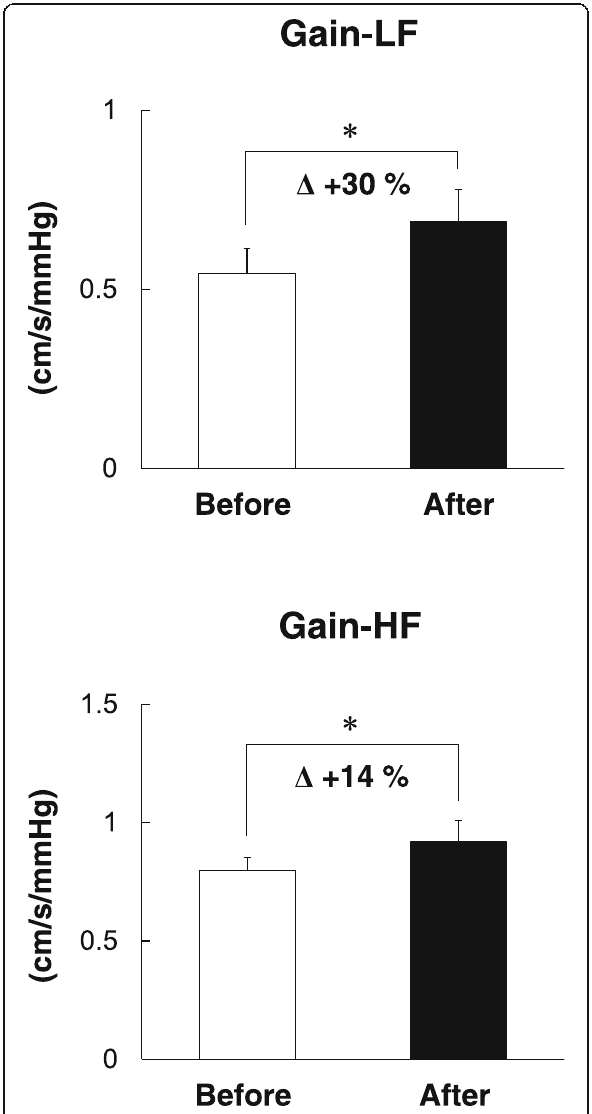
Fig. 2 Group-averaged transfer function gain before and after the 14-day confinement period in an isolated environment. * P < 0.05 comparison between before and after the 14-day confinement period in an isolated environment. Δ , percentage change between before and after the 14-day confinement period in an isolated environment. Average percentage changes of transfer function gain were calculated from the percentage changes of each